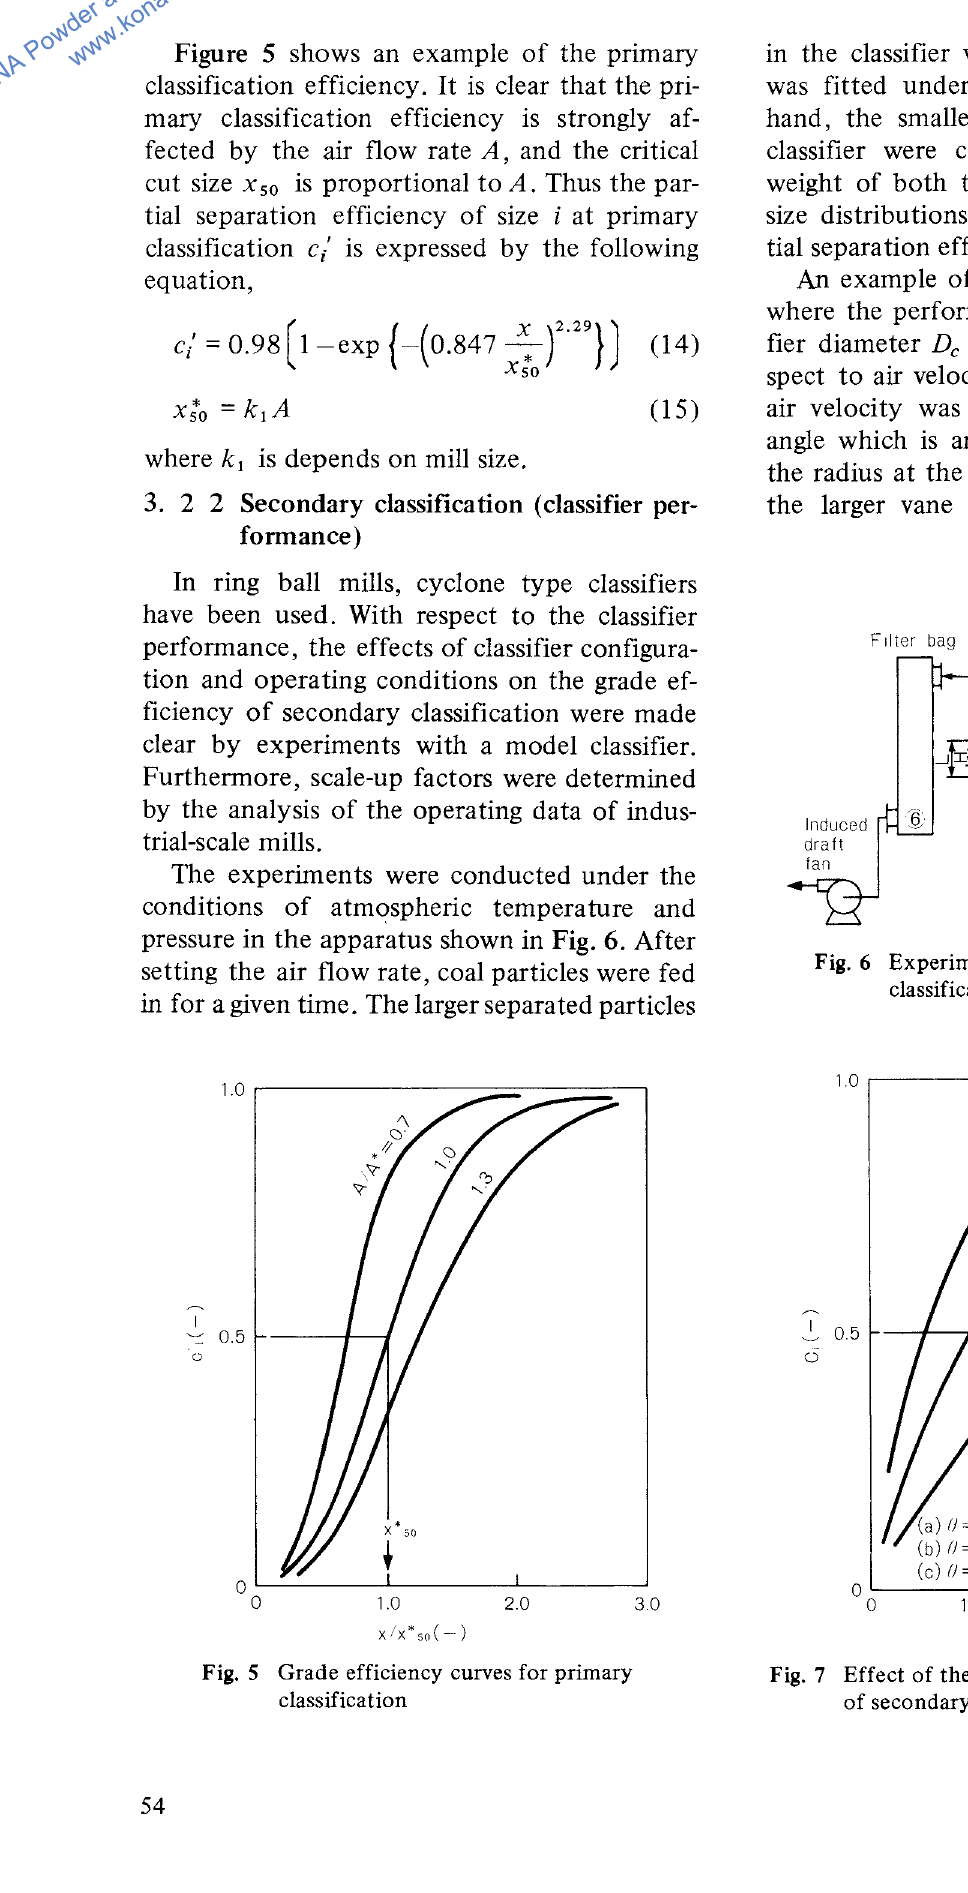
Fig. 5 Grade efficiency curves for primary classification